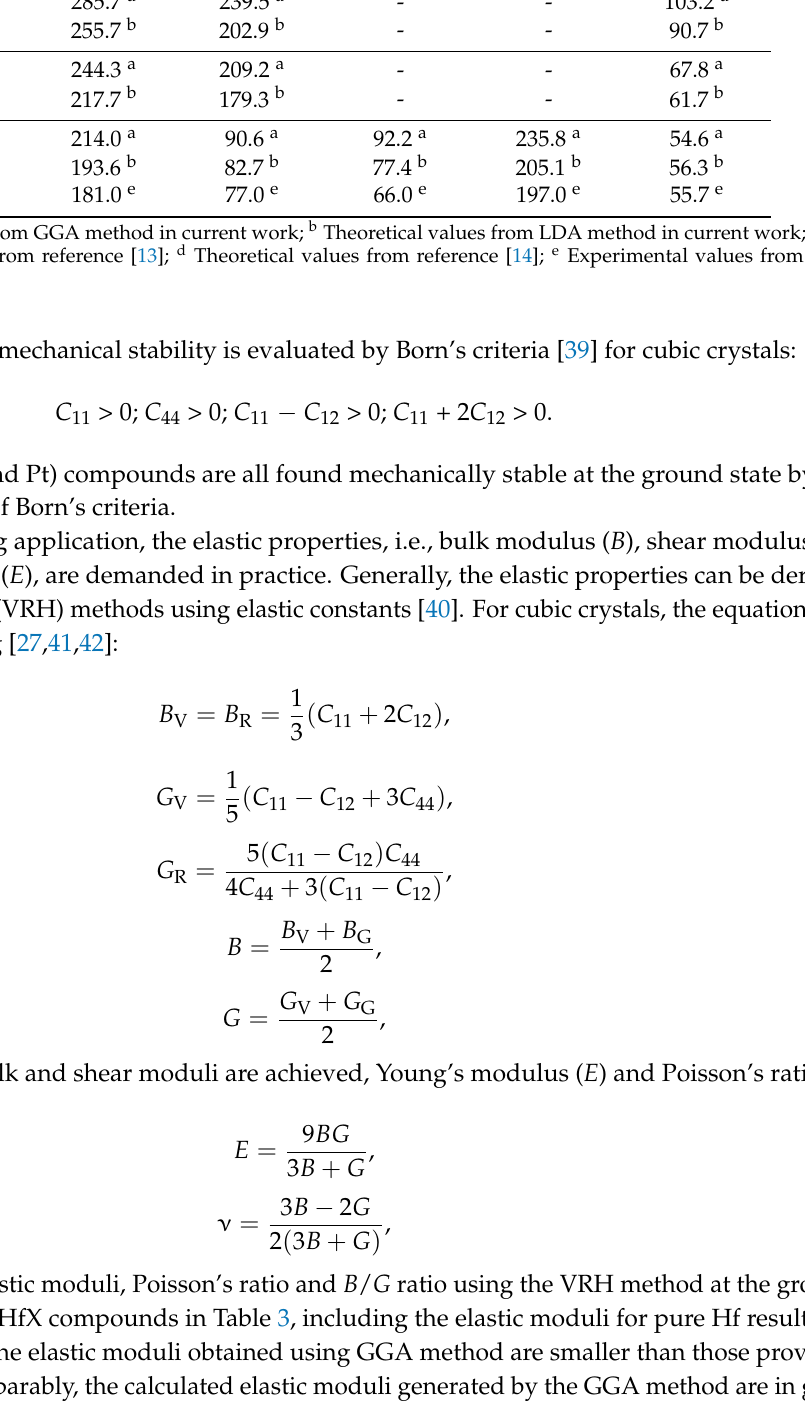
Table 2. The elastic constants ( C ij ) for HfX (X = Os, Ir and Pt). Compounds C 11 (GPa) C 12 (GPa) C 13 (GPa) C 33 (GPa) C 44 (GPa) 402.1 a 149.7 a - - 121.0 a 436.5 b 179.3 b - - 130.5 b HfOs 393.7 c 139.8 c - - 110.1 c 366.1 d 152.6 d - - 105.6 d 285.7 a 239.5 a - - 103.2 a HfIr 255.7 b 202.9 b - - 90.7 b 244.3 a 209.2 a - - 67.8 a HfPt 217.7 b 179.3 b - - 61.7 b 214.0 a 90.6 a 92.2 a 235.8 a 193.6 b 82.7 b 77.4 b Hf 77.0 e 55.7